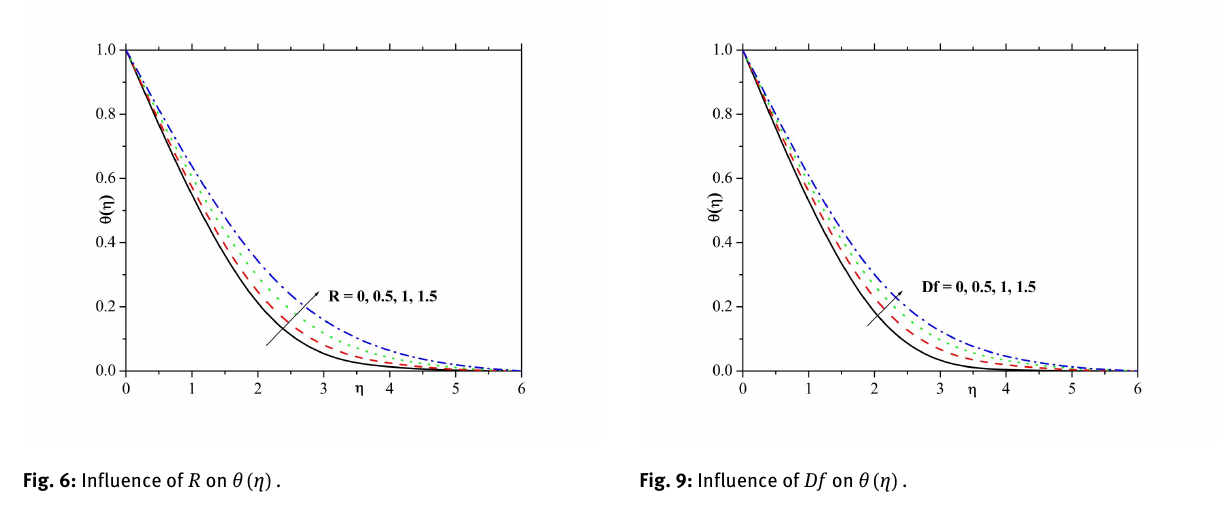
Fig. 6: Influence of R on θ ( η ) .